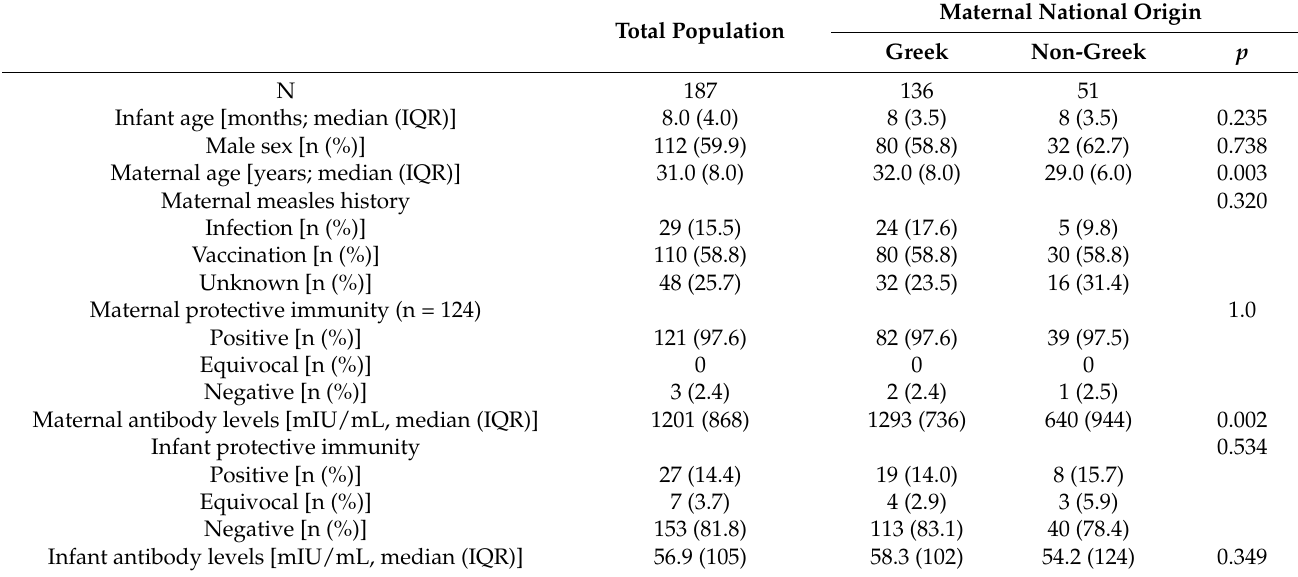
Table 2. Infant and maternal demographics and measles humoral immune status in the total cohort and the maternal national origin-related subgroups. Total